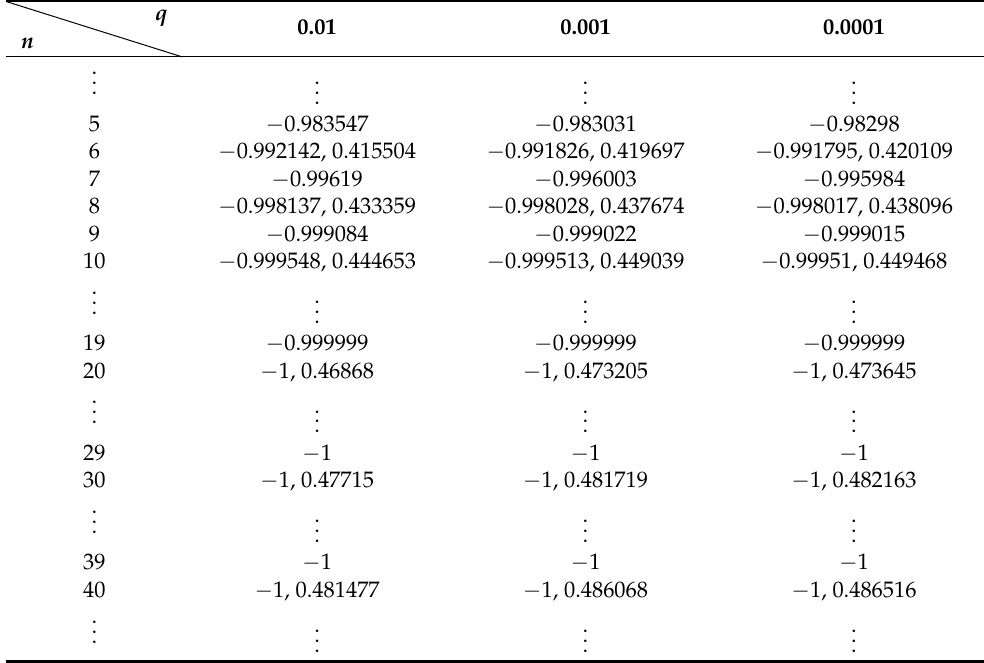
Table 2. Approximate real roots of S n , q ( x )